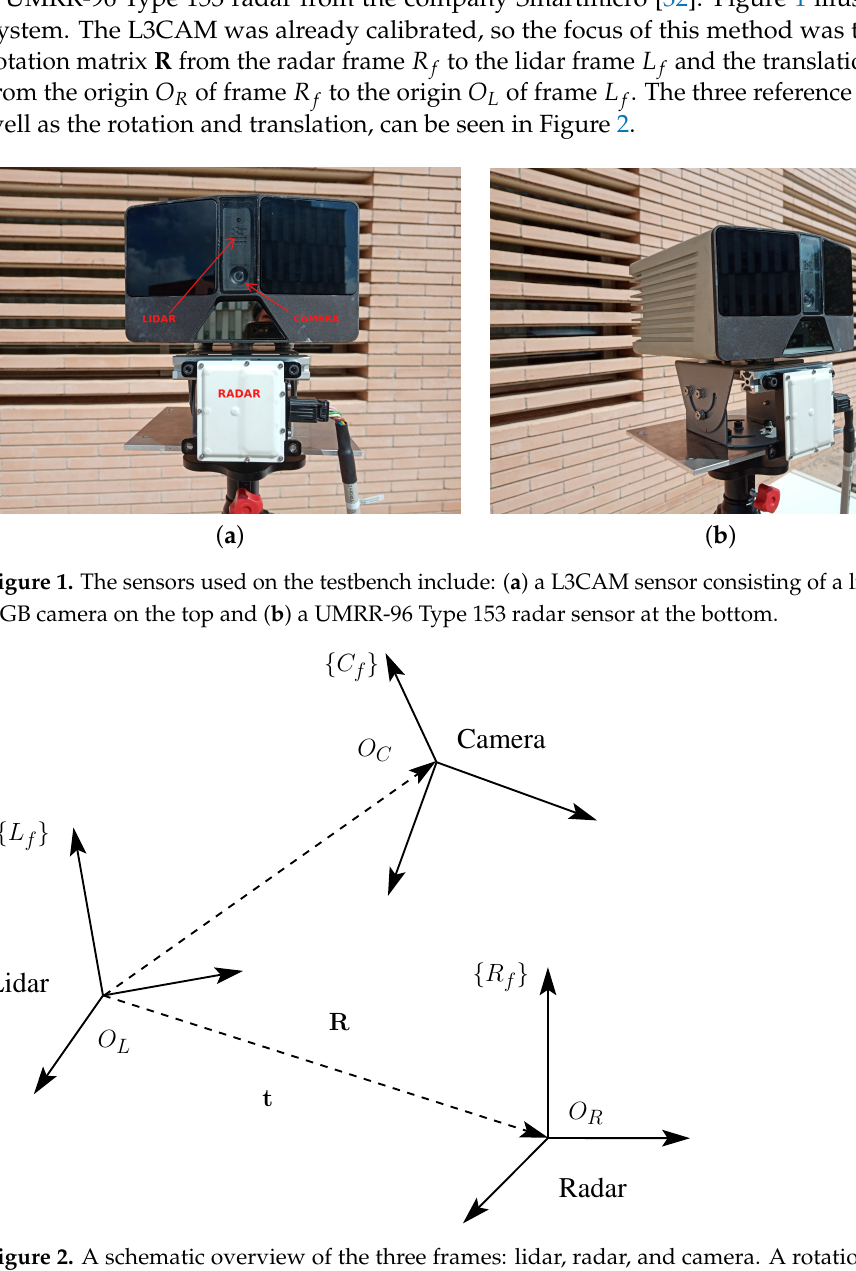
Figure 2. A schematic overview of the three frames: lidar, radar, and camera. A rotation matrix R and translation vector t from the radar to the lidar frames are also